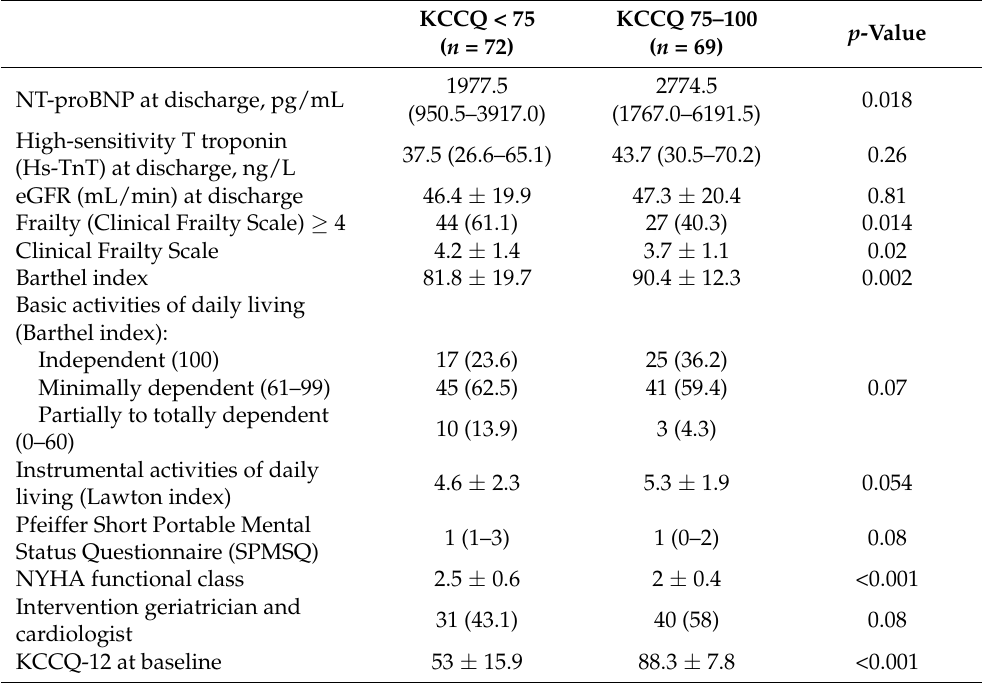
Table 2. Hospitalization and first appointment characteristics.